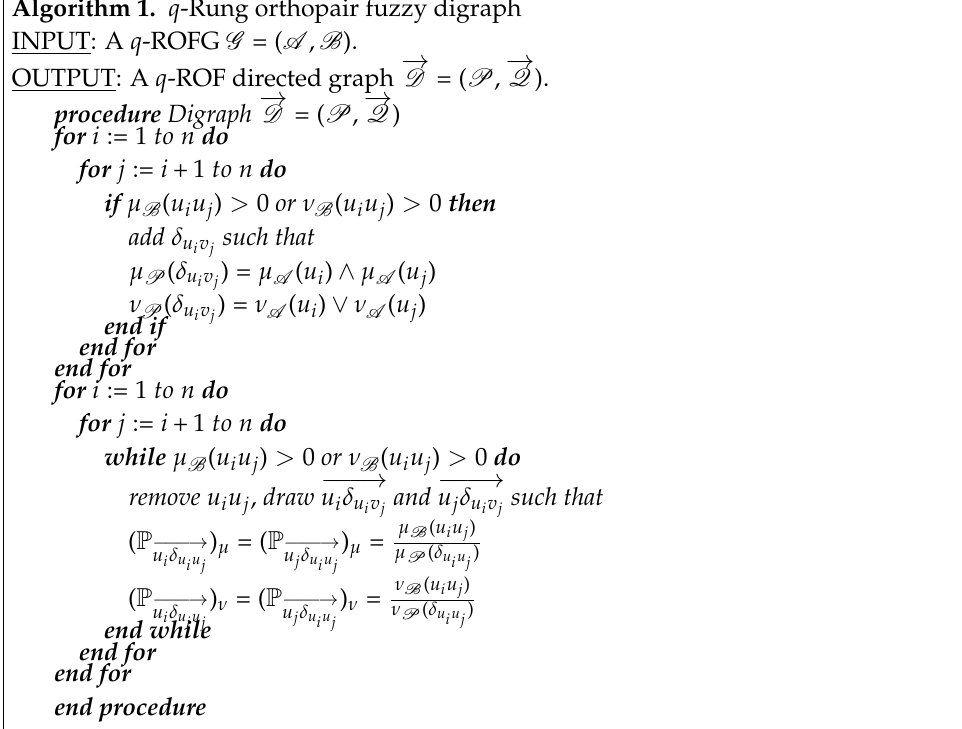
Algorithm 1. q -Rung orthopair fuzzy